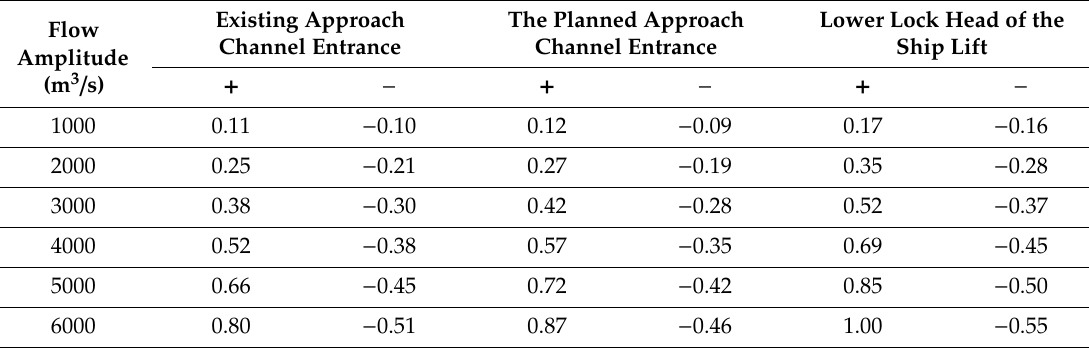
Figure 10. Water level variation process with regulation time. ( a ) Lower lock head of the ship lift; ( b ). Table 1. List of the maximum water level amplitudes (unit,